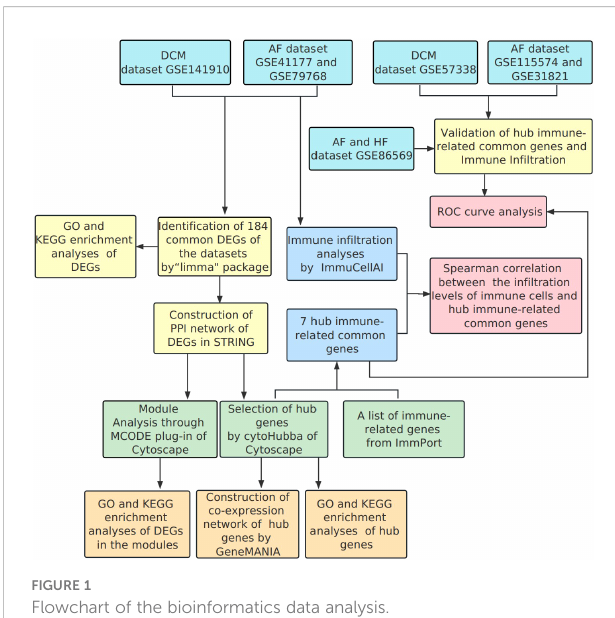
FIGURE 1 Flowchart of the bioinformatics data